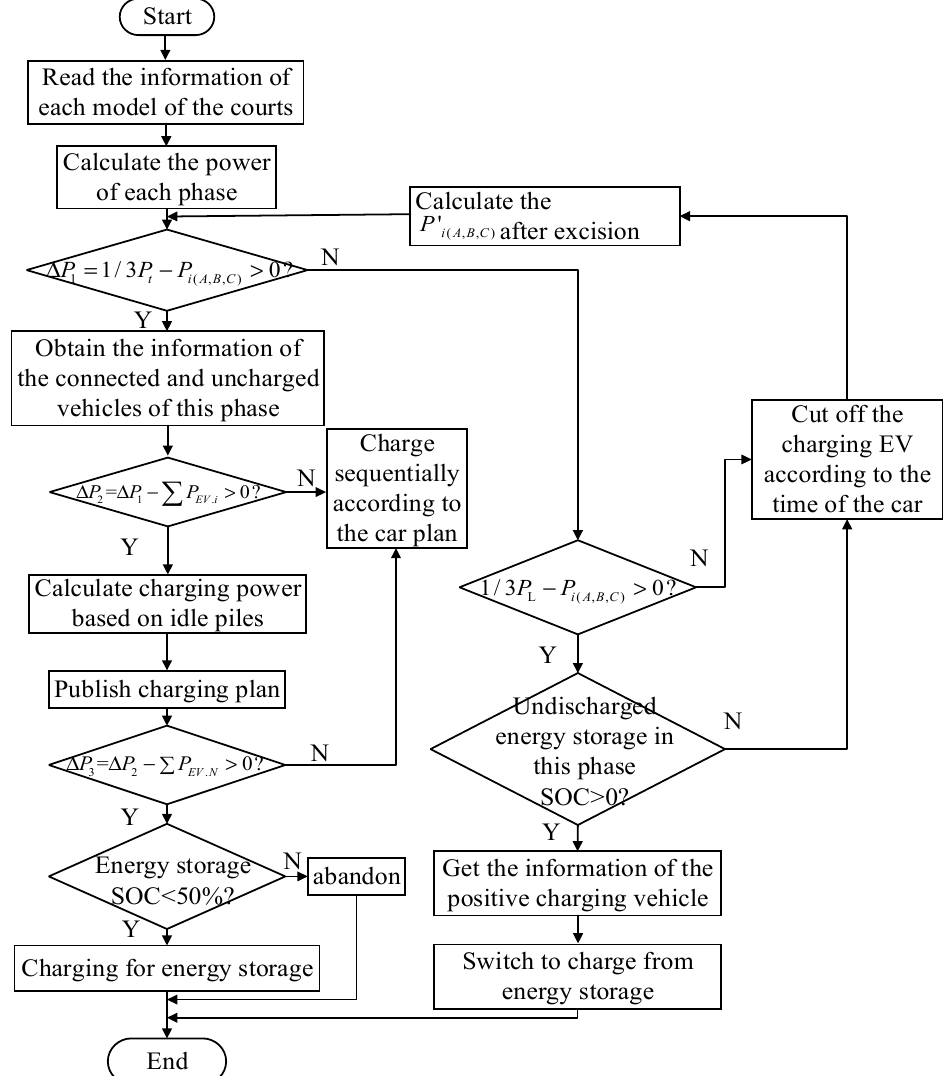
Figure 4. Flow chart of ordered charging strategy.